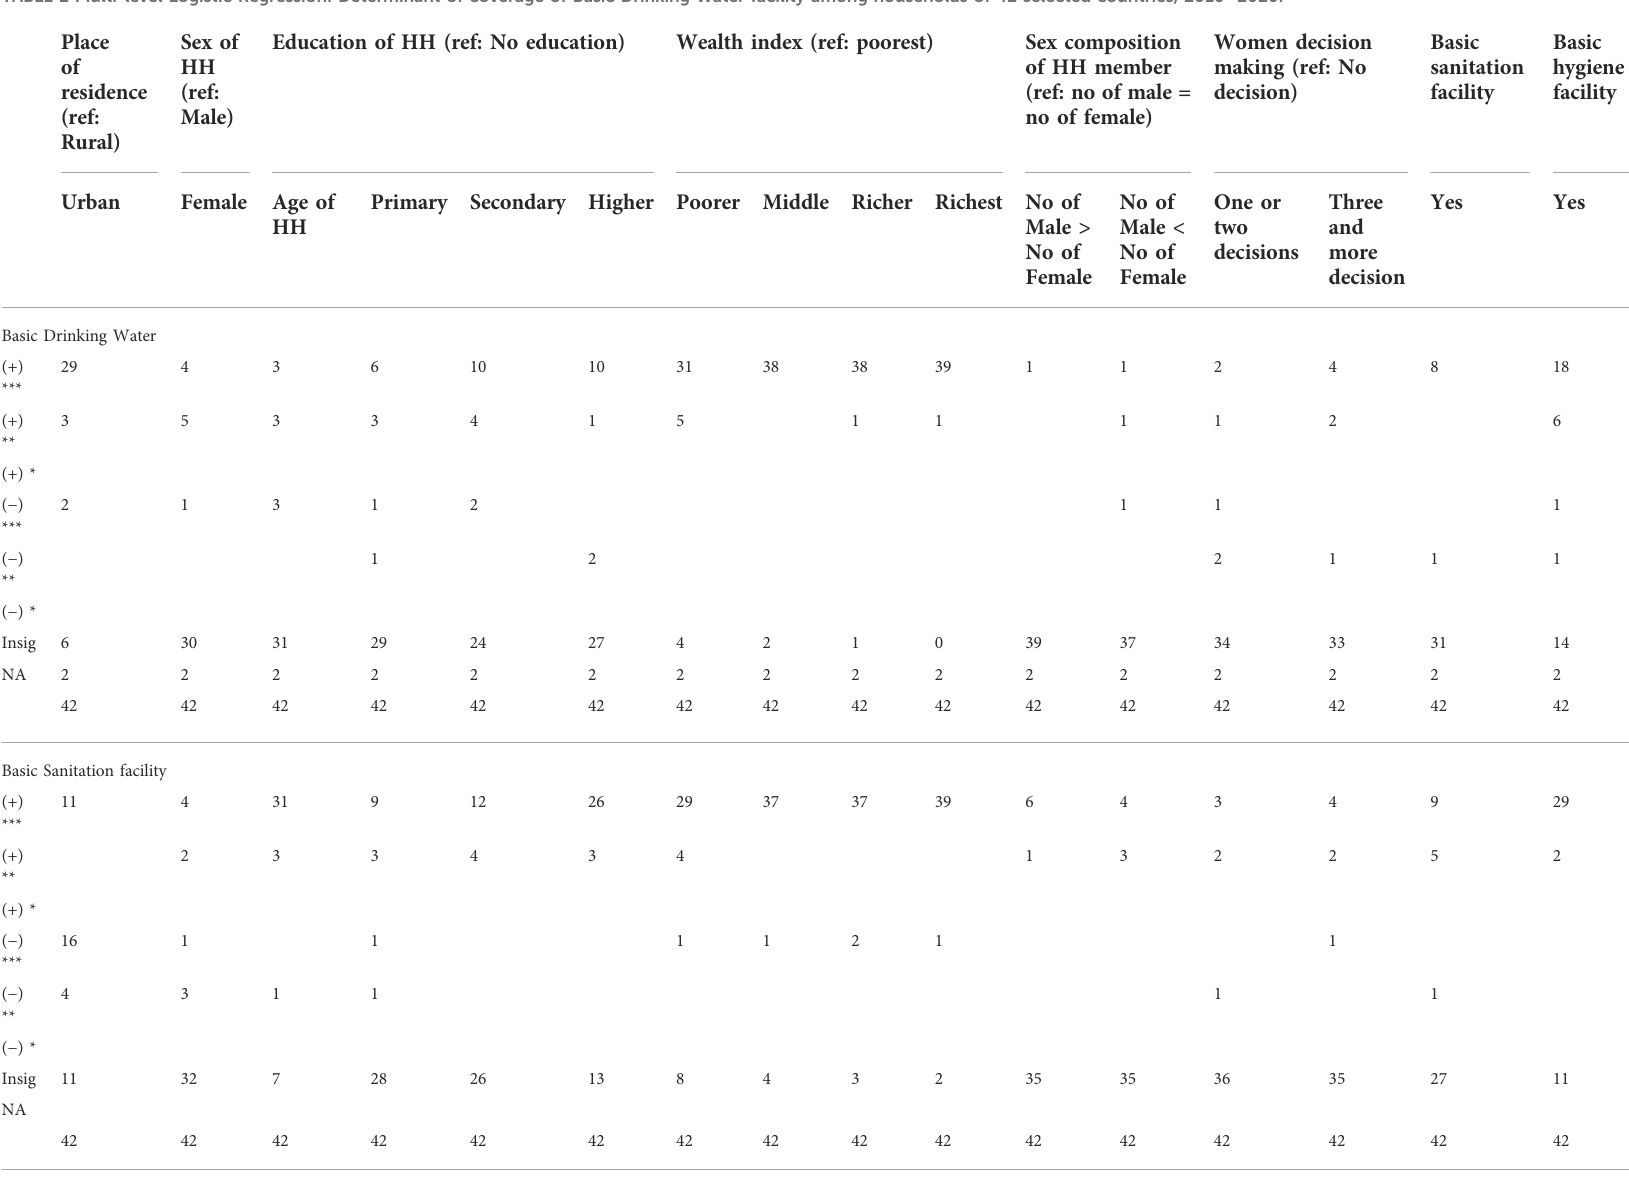
TABLE 2 Multi-level Logistic Regression: Determinant of coverage of Basic Drinking Water facility among households of 42 selected countries, 2010 – 2020. Place